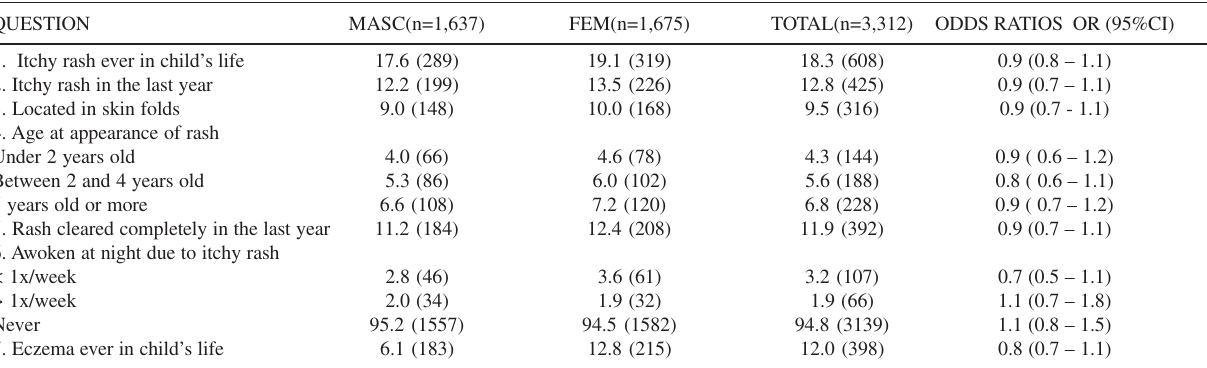
Table 3. Prevalence of eczema (%) symptoms, according to gender, in 3,312 6-7 year-old students from the western districts of São Paulo